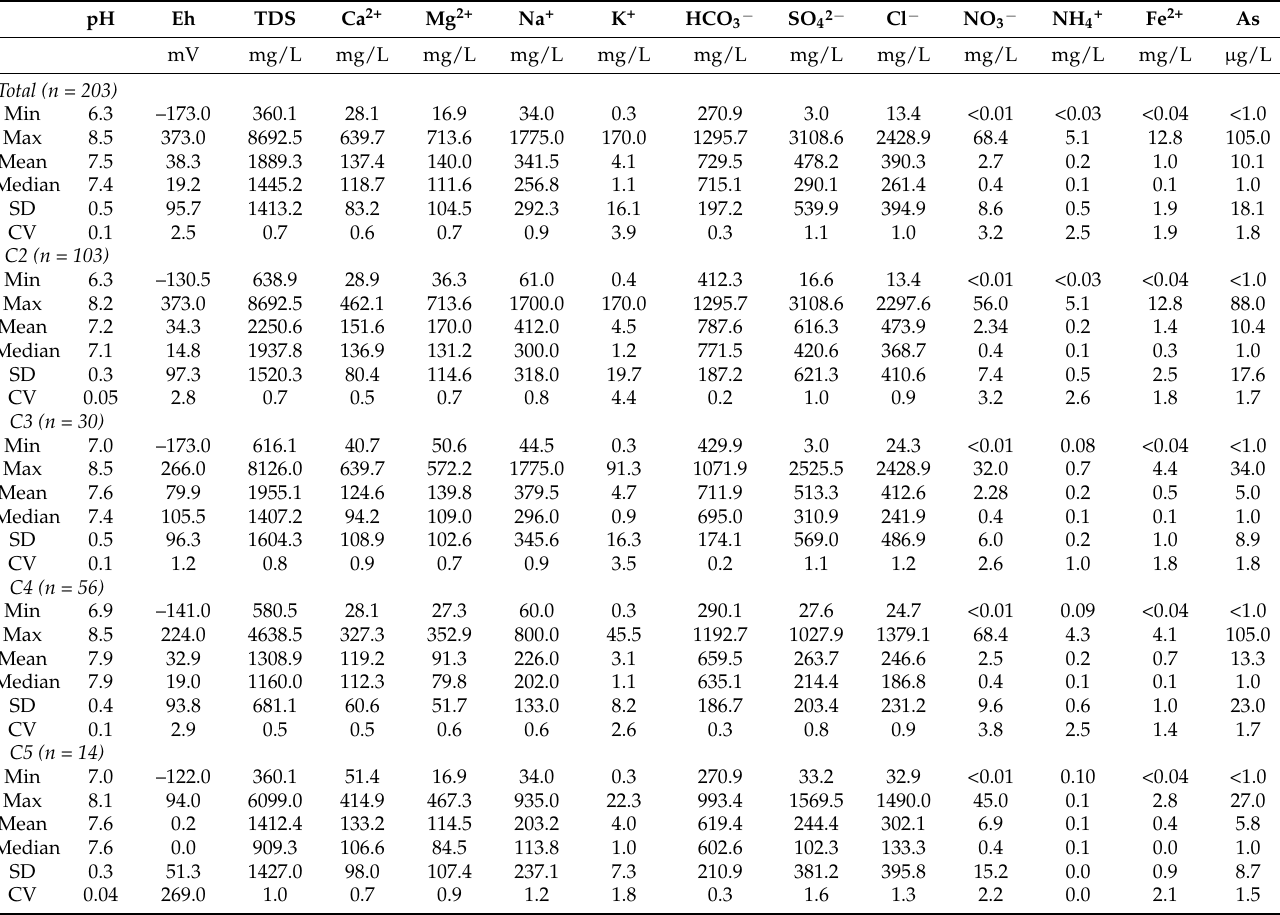
Table 1. Statistical summary of the major physical–chemical parameters of the groundwater in the study